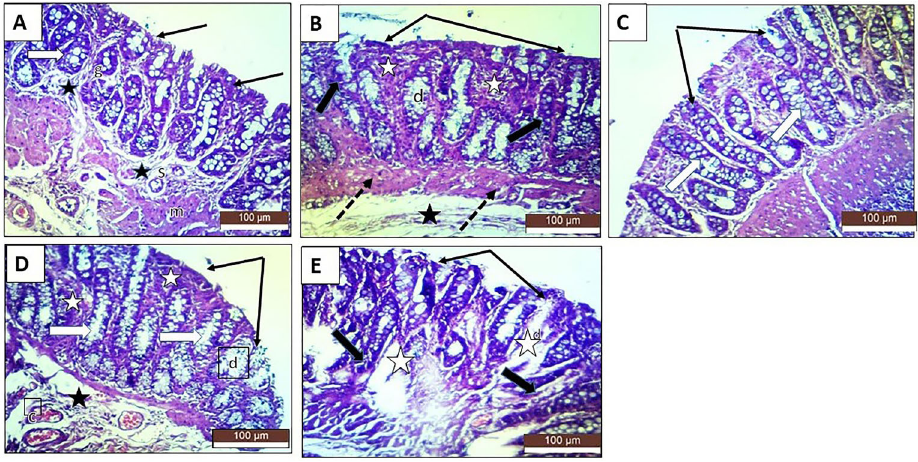
Figure 2. Photomicrographs of rat colonic sections stained with H&E ( (cid:4) 20, scale bar 100 m m). A , The normal control group shows normal mucosal layers, intact surface epithelium (black arrows), normally shaped crypts with numerous goblet cells (white arrow), and narrow connective tissue submucosa (black stars). Tunica submucosa (s) consisting of loose connective tissue rich in blood vessels and lymph vessels, and muscularis mucosae (m) consisting of inner circular and outer longitudinal smooth muscle fi bers are seen. B , The positive control group shows loss of surface crypt epithelium (black arrows) and destruction of crypts that appear darker with less goblet cells (d). The regions of the lost crypts are replaced by in fl ammatory in fi ltrate and fi brous tissue (white stars). Thickened fi brosed muscularis muscle and widened submucosa due to edema (black star) are seen. C , The sulfasalazine group shows marked improvement with nearly normal appearance of colonic surface (thin black arrows) and crypts (thick white arrows) with few desquamated cells, especially colonocytes. D , The oral ro fl umilast group shows moderate improvement with focal loss of surface crypt cells (black arrows) and some lost crypts (white stars). Other crypts appear normal with numerous goblet cells (white arrows). The submucosa is somewhat edematous (black star) with congested blood vessels (c). The colonic wall displays thickening with patches of fi brosis and epithelial desquamation (d). E , The rectal ro fl umilast group shows mild improvement with apparent thickening of the colonic mucosa with numerous patches of crypt loss (white stars) and dark degenerated surface cells (thin black arrows). The crypts appear deformed, degenerated, and dark, with few goblet cells (thick black arrows). Desquamated colonic cells (d), especially the cells lining the crypts, and numerous congested blood vessels in the propria submucosa are